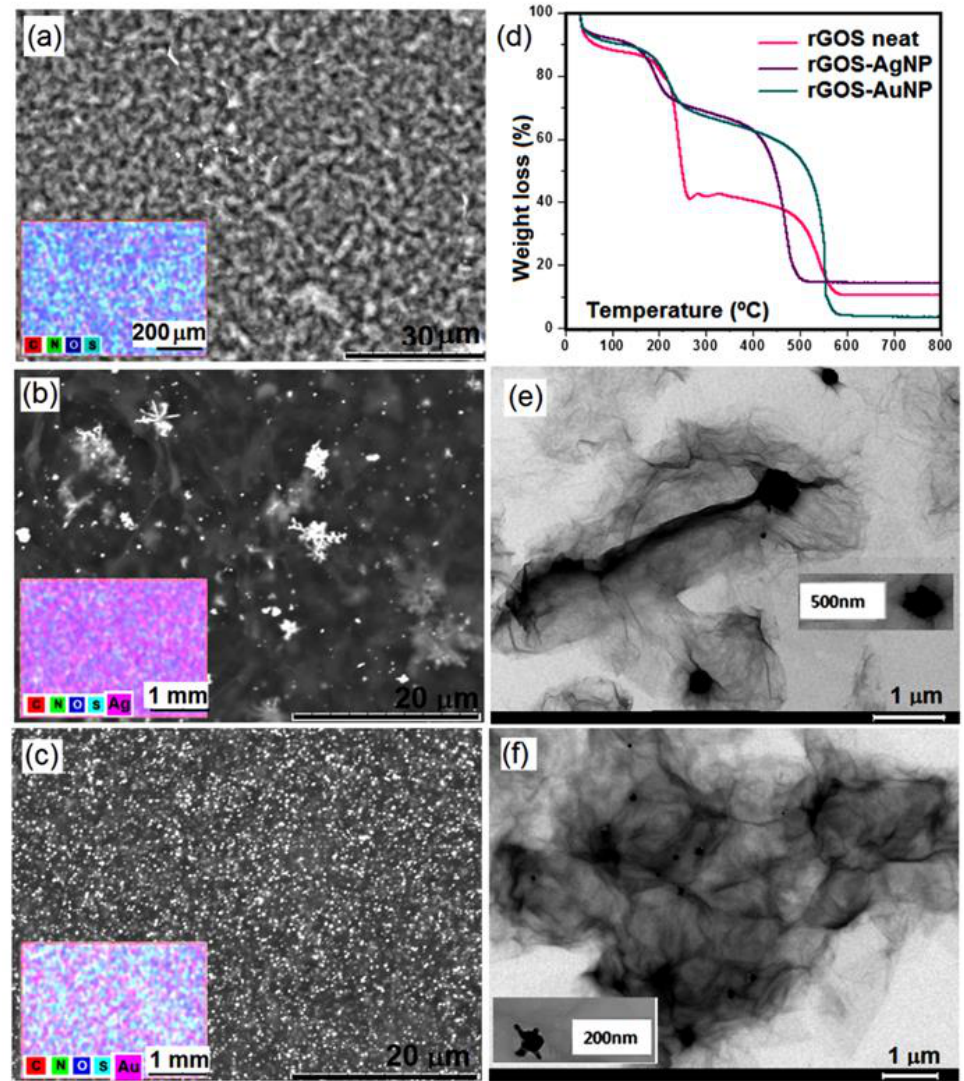
Figure 1. Characteristics of rGOS-AgNP and rGOS-AuNP hybrid films: ( a ) SEM image of neat rGOS, inset: EDX map of the same film; ( b ) SEM image of rGOS-AgNP film, inset: EDX map of the same film; ( c ) SEM image of rGOS-AuNP film, inset: EDX map of the same film; ( d ) TGA curves of hybrid films; ( e ) TEM image of rGOS-AgNP film; ( f ) TEM image of rGOS-AuNP film. In the insets of ( e ) and ( f ) single Ag and Au nanoparticle is shown, respectively. TGA curves of the nanostructures obtained in presence of oxygen are presented in Figure 1d. Except on thermal stability of the composite structures, TGA curves provide